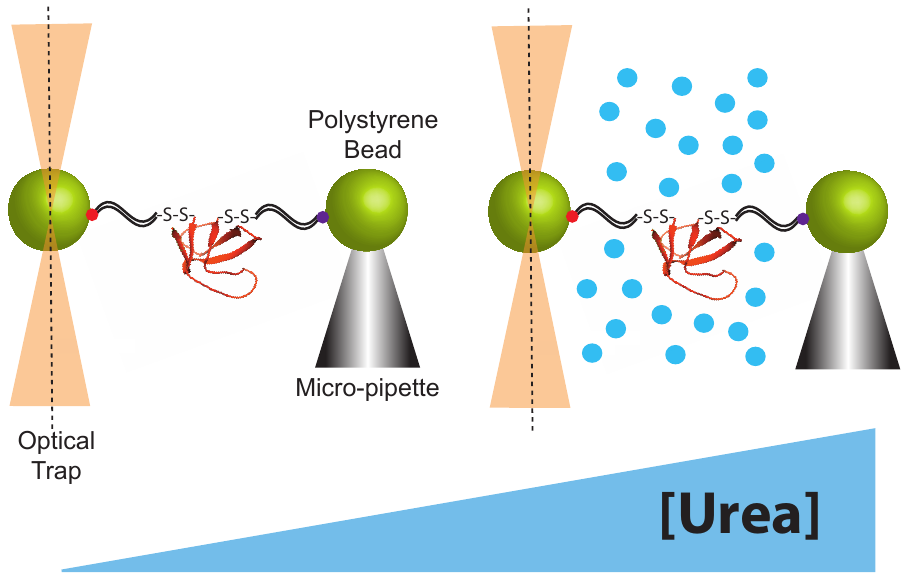
Figure 2. Schematic representation of the optical tweezers set-up used in chemo-mechanical unfolding